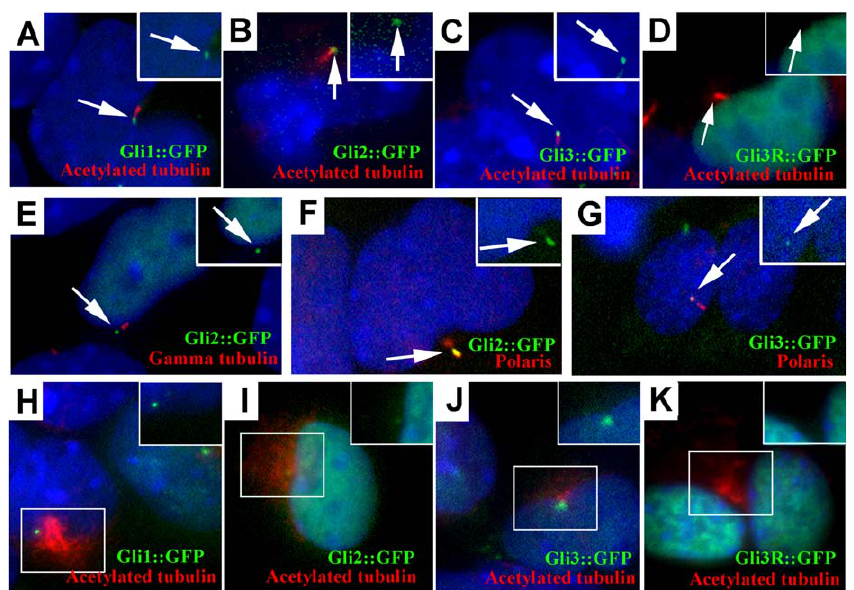
Figure 5. GFP-Tagged Gli Proteins Localize to the Distal Tip of the Cilium in Primary Limb Cell Cultures (A–D) Cells were isolated from limb buds of wild-type embryos at E11.5 and infected with the indicated adenovirus. All three full-length GFP-tagged Gli proteins (green) localize to a domain in the cilium axoneme, which is visualized with anti-acetylated a -tubulin staining (red). In contrast, Gli3R::GFP is restricted to the nucleus and is not detected in this domain (D). (E) The full-length Gli::GFP proteins (Gli2::GFP shown here) do not colocalize with the basal body at the base of the cilium, which is visualized with anti- c -tubulin staining (red), indicating that the full-length Gli proteins localize to the tips of the cilia. (F and G) Gli2::GFP (F) and Gli3::GFP (G) colocalize with a subdomain of Polaris (red) at the distal tip of the cilium. (H–K) In Tg737 D 2–3 b -gal mutant limb bud cells, the GFP-tagged Gli1 (H), Gli2 (I), and Gli3 (J) proteins localize to the nucleus and in the region of stabilized microtubules around the MTOC marked by anti-acetylated a -tubulin. In contrast, the processed form of Gli3 (Gli3R::GFP) (K) is detected only in the nucleus. Insets in all panels show the GFP (green) and nuclear (blue) staining only for the indicated cilium (arrow) or region (box). DOI: 10.1371/journal.pgen.0010053.g005